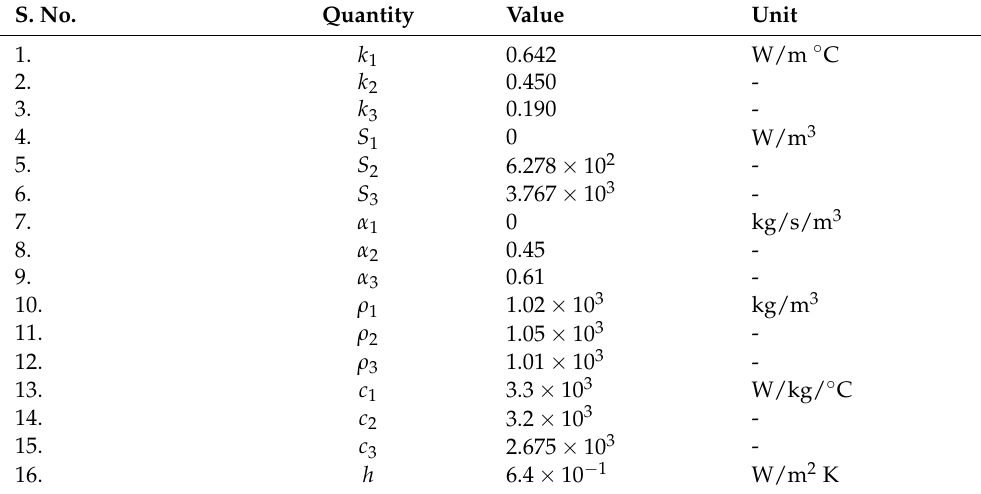
Table 1. Numerical values of the parameters of the skin.